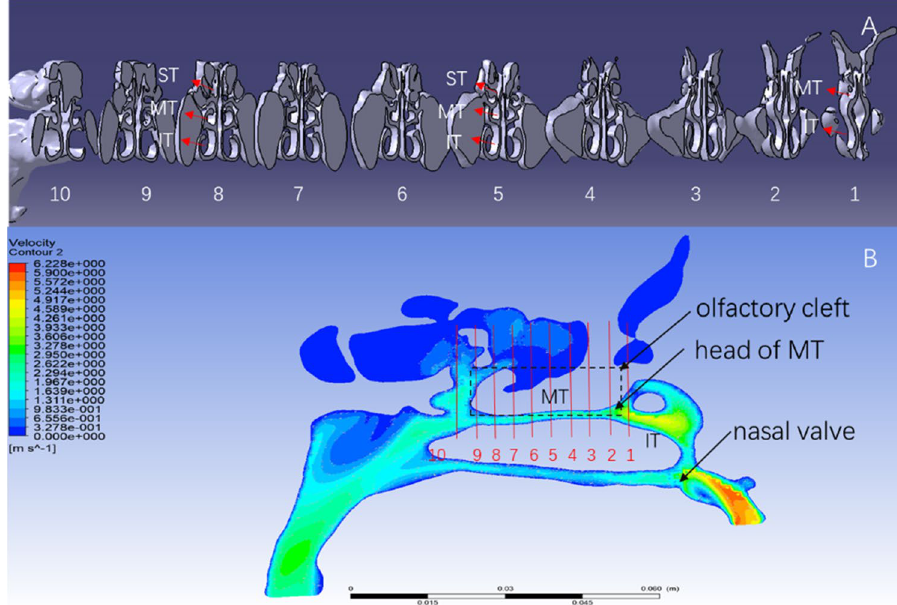
Figure 1. Overall sagittal segmentation view of the cross-sectional system. ( A ) Sagittal section view; ( B ) cross- sectional airflow system division (1–10 represents 10 cross-sectional systems; IT: inferior turbinate, MT: middle turbinate, ST: superior turbinate). (created by ANSYS 17.0: Academic Teaching Mechanical and CFD, ANSYS END USER CERTIFICATE, Sun Yat-sen University(#1016974)).